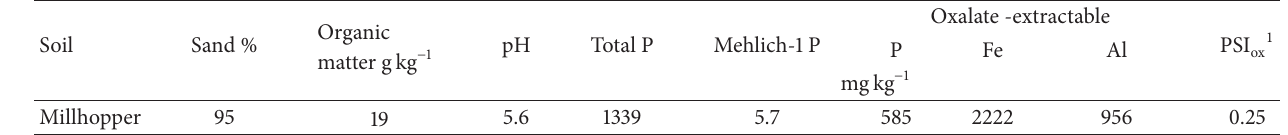
Table 1: Selected soil chemical